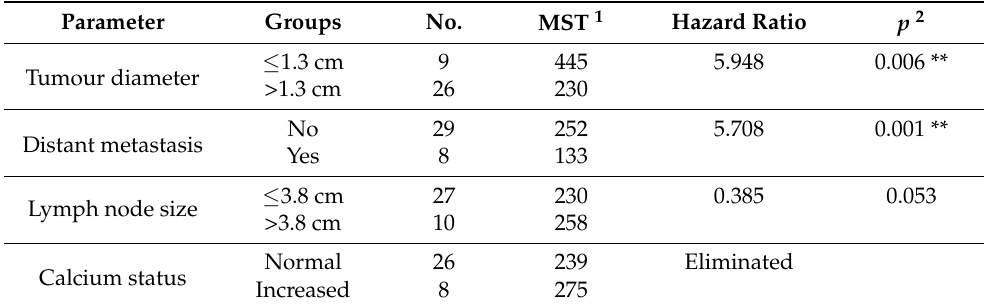
Table 5. Optimised multivariate model for the effect of clinical variables on progression-free interval. Parameter